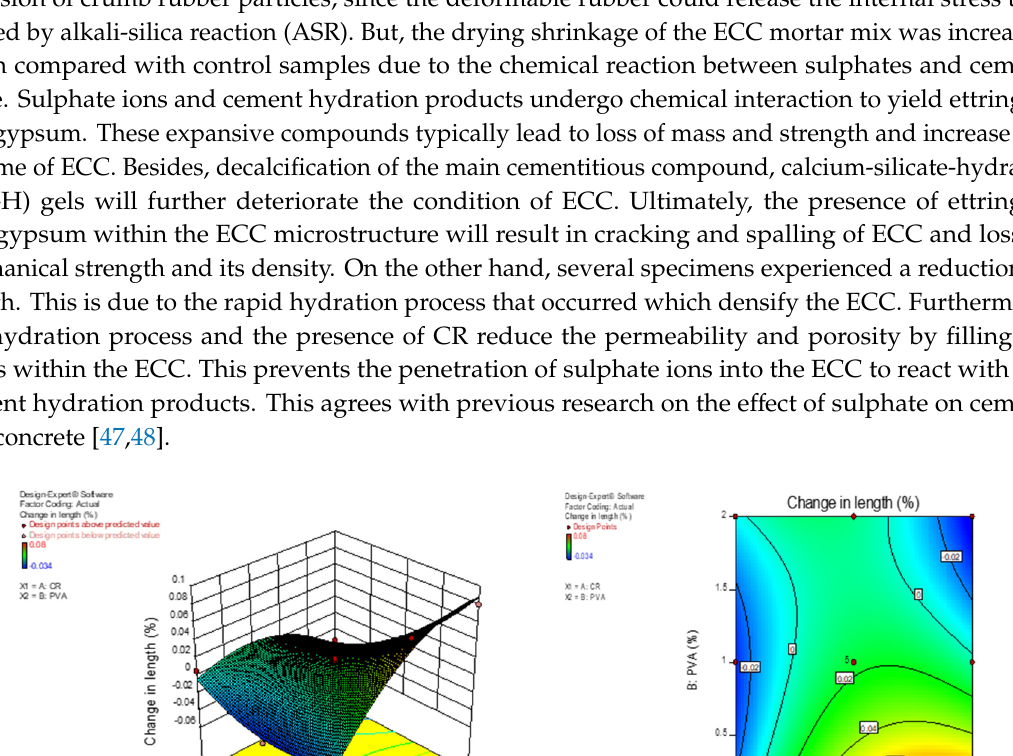
Table 4. Summary of variance analysis.